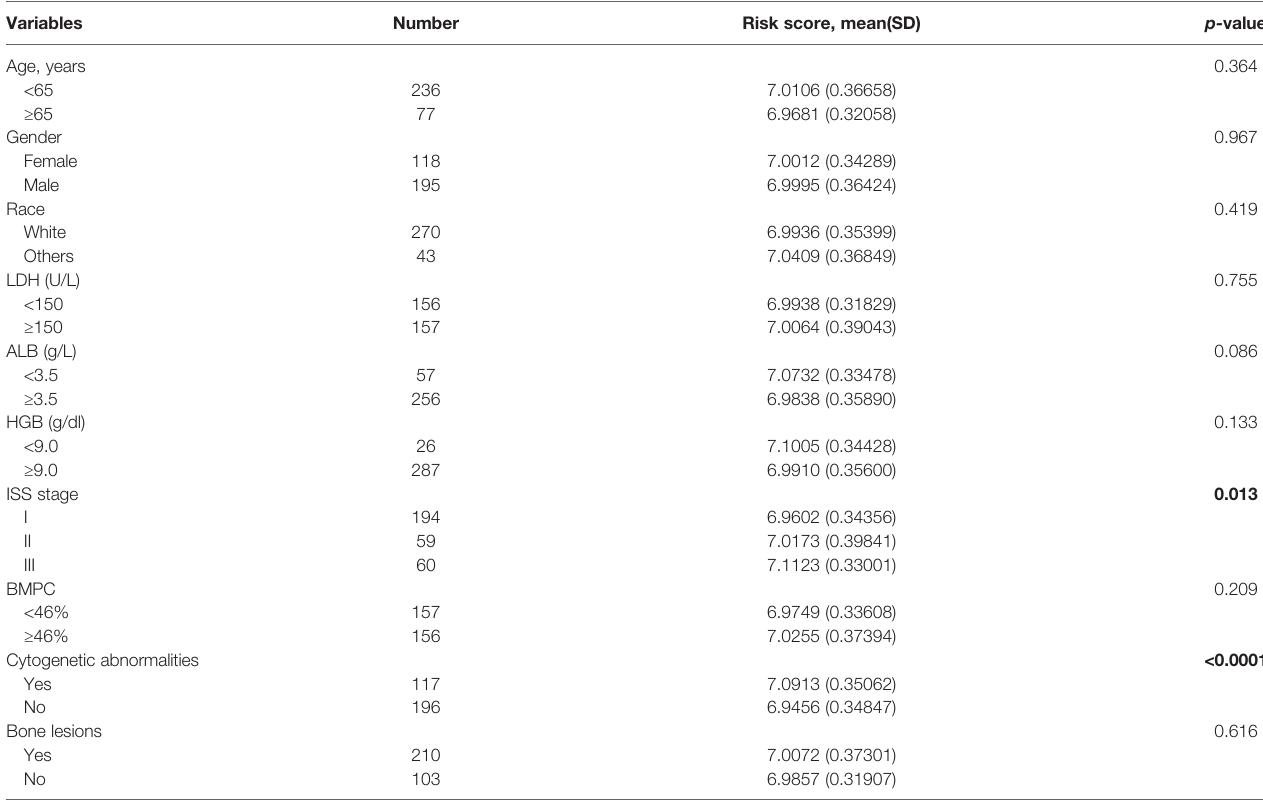
TABLE 2 | The correlation of prognostic risk signature and clinical